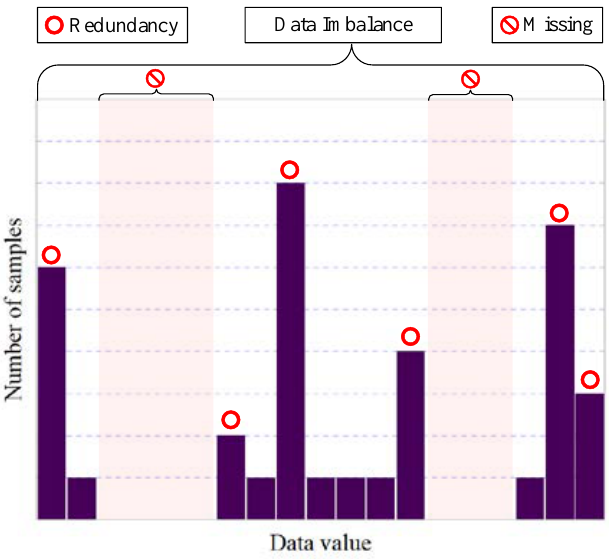
Figure 1. Data problems in condition monitoring.